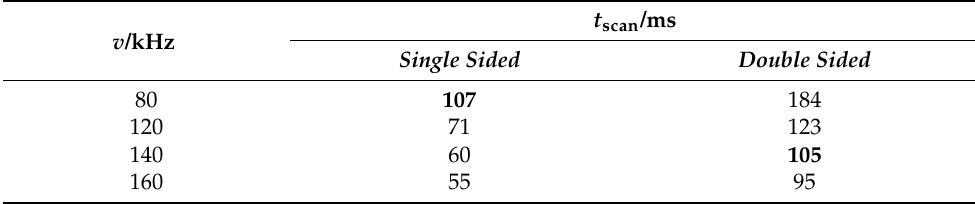
Table 2. Scan times t scan of different combinations of optical velocity v and acquisition mode at